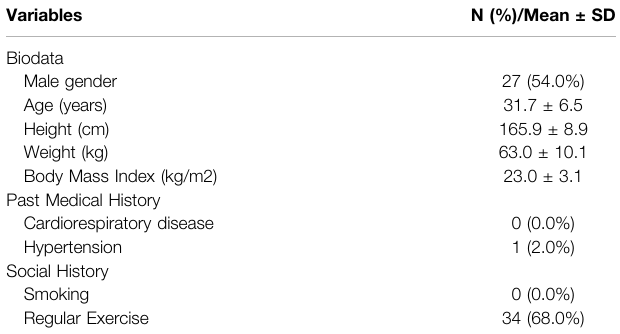
TABLE 1 | Baseline